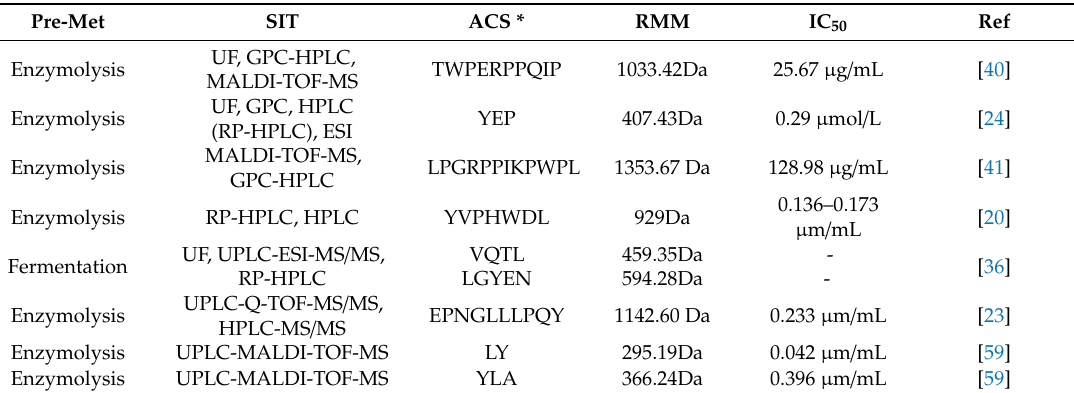
Table 3. ACE inhibitor peptides that have been